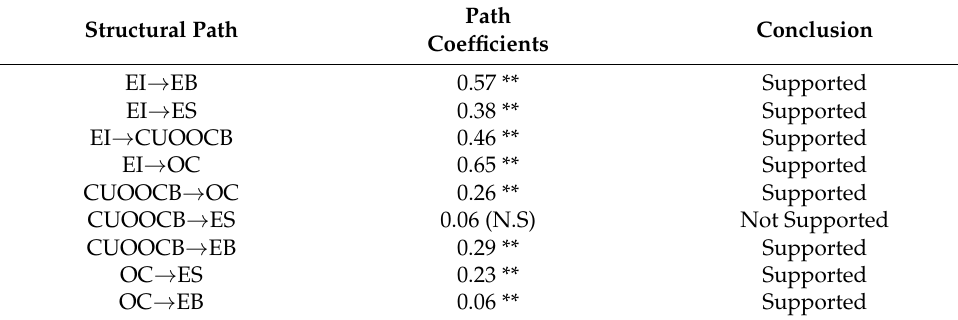
Table 5. Hypothesis testing and path coefficient (direct